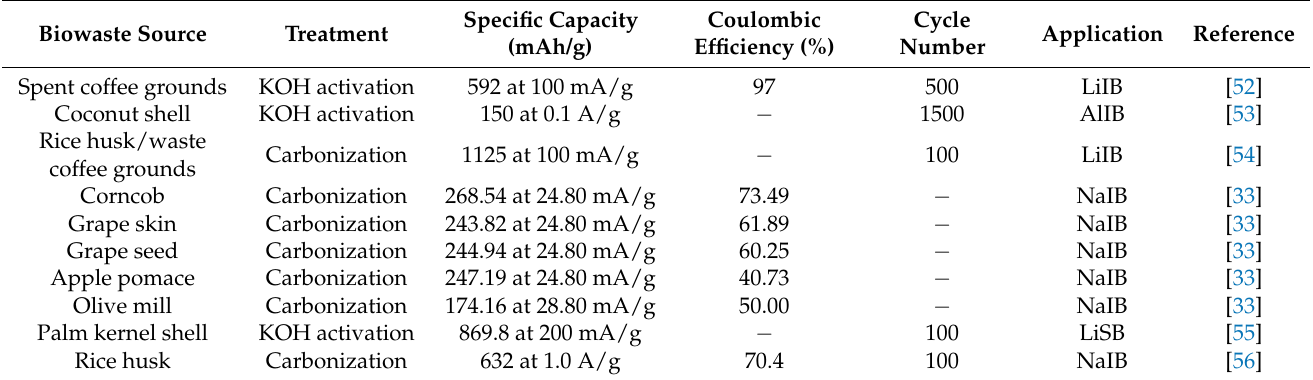
Table 3. Electrochemical performance of some reported biowaste-based activated carbon for battery